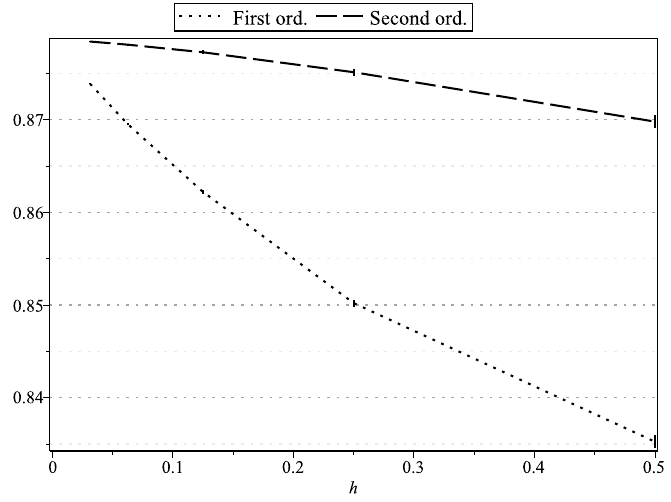
Figure 15. E e − ( 3/4 ˆ X x 1 ) as functions of h : σ = 0.8, θ = 0.5, β = 0.5, x 0 = 1.5.